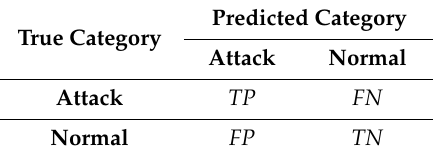
Table 2. Confusion matrix.